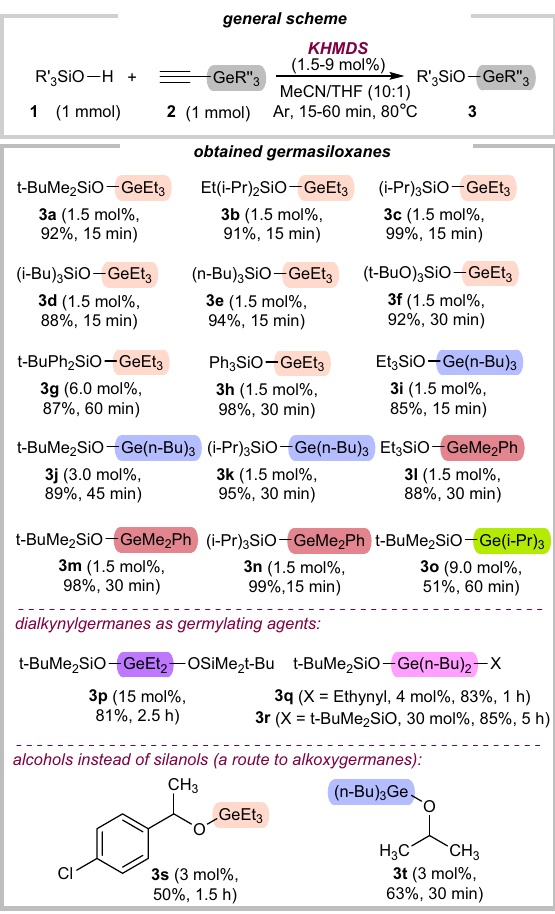
Figure 2. Substrate scope for O-germylation of various silanols.